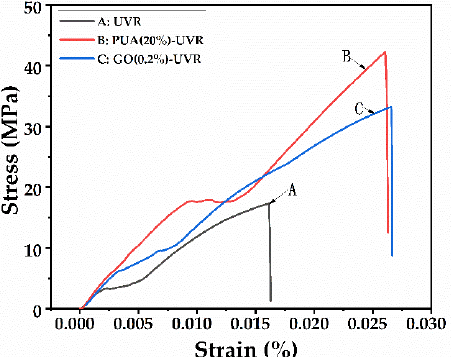
Figure 6. Tensile stress-strain of the free − radical/cationic hybrid, polyurethane acrylates (20%) modified, and graphene oxide (0.2%) modified photosensitive resins. The Young’s modulus of the photosensitive resins decreased from 1820.12 MPa to 1726.12 MPa as the mass fraction of PUA increased from 0% to 15% PUA (Table 6), rep- resenting a reduction of 5.44% compared to that of the unmodified resin. The maximum Young’s modulus of 2295.14 MPa was observed at 20% PUA. These results indicate that 15% PUA has a significant toughening effect on the mechanical properties of the photo- sensitive resin. The GO-modified resin exhibited a similar trend. The Young’s modulus initially decreased as the GO mass fraction increased, reaching a minimum of 1549.99 at